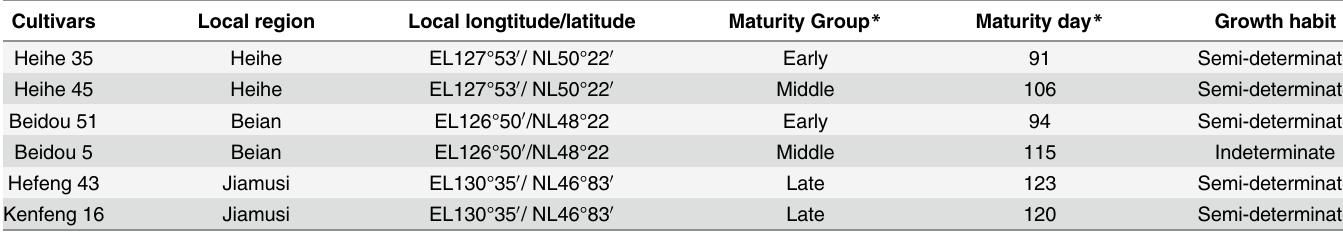
Table 1. The information of cultivars used in this